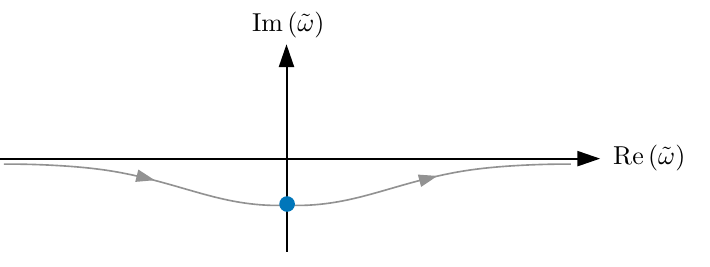
Figure 1 . The integrand in eq. (2.13) features a single saddle point that lies on the imaginary axis (blue dot). Within the saddle-point approximation, the contour of integration is deformed so that it passes through the saddle point (grey line), and the leading contribution to the integral is given by evaluating the integrand on the saddle point